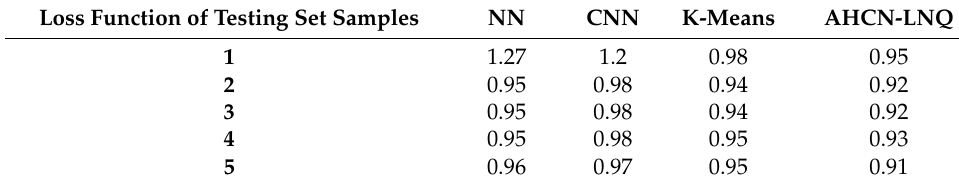
Table 4. Loss function for testing